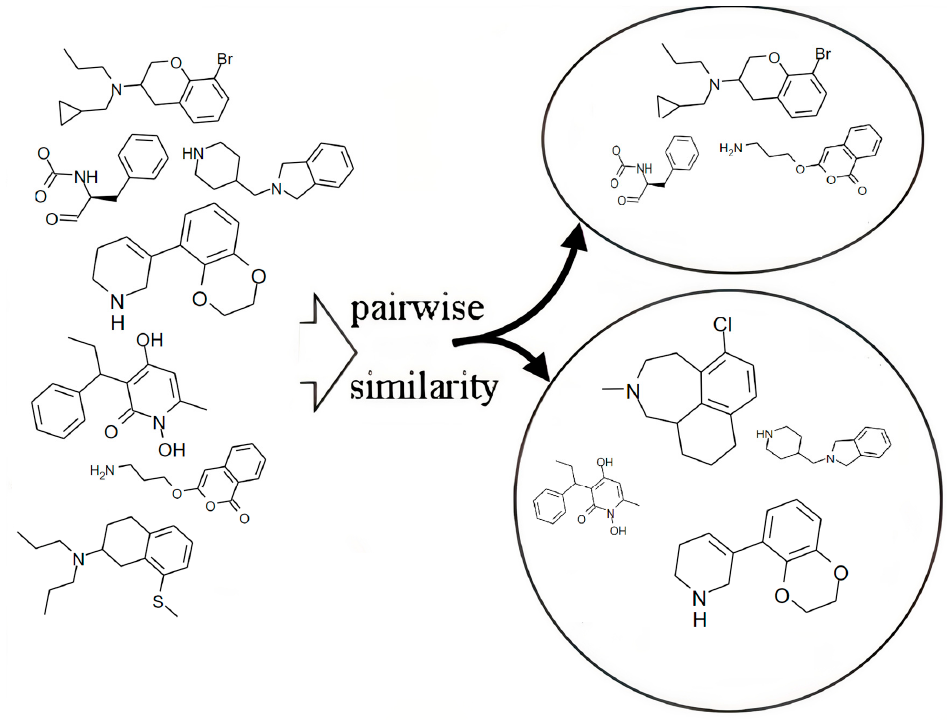
Figure 14. The average pairwise similarity (MPS) across each set of active molecules. Box plots are the chart type that is used to visually present the distribution of all numerical data based on their average values and quartiles (or percentiles). Generally, box plots are applied in descriptive statistics since they help in overviewing the set of distributed data along with its range. The right-hand side of Figure 15 depicts the creation of a box, while the median MPS value is represented by the medium segment in the box. The first and third quartiles’ MPS values are shown in the lower quartile and the upper quartile, while an empty circle represents the